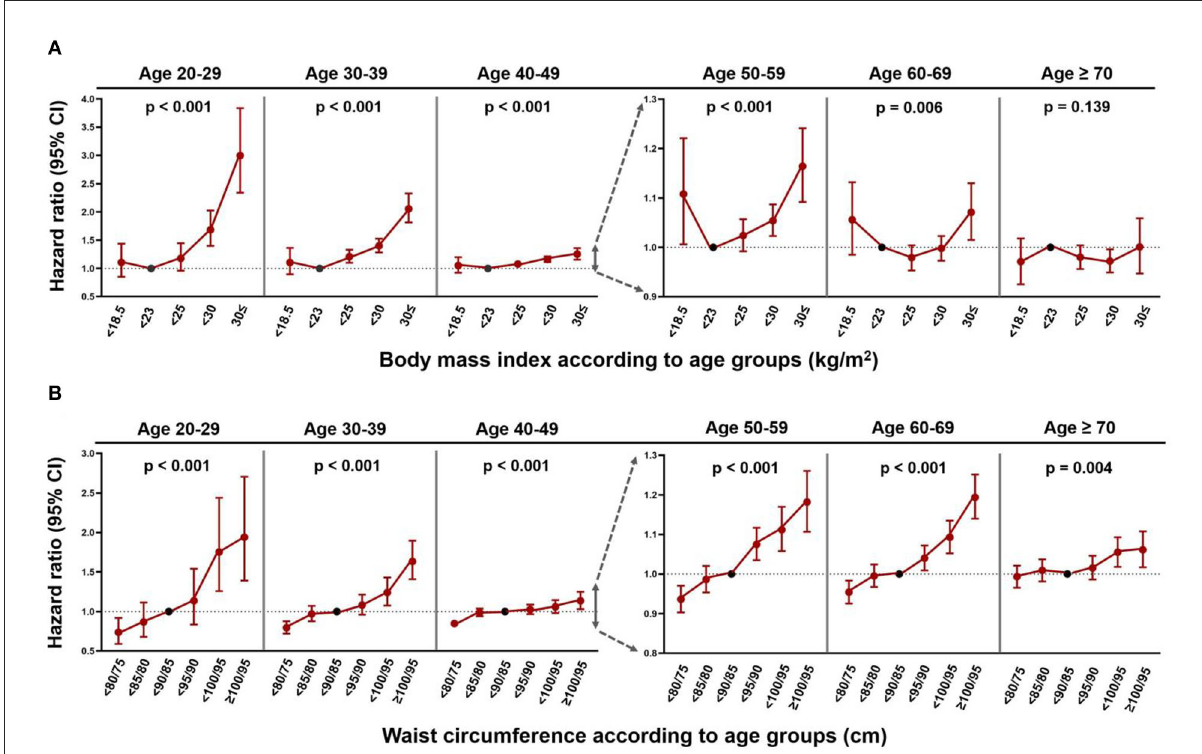
FIGURE3 The risk of ischaemic stroke according to obesity parameters in the different age groups. (A) BMI. (B) WC. CI, confidence interval . P -values indicate the statistical significance of the association between obesity parameters (body mass index, waist circumference) and the risk of ischaemic stroke in each age group by calculating obesity parameters as continuous variables and adjusting covariates noted in model